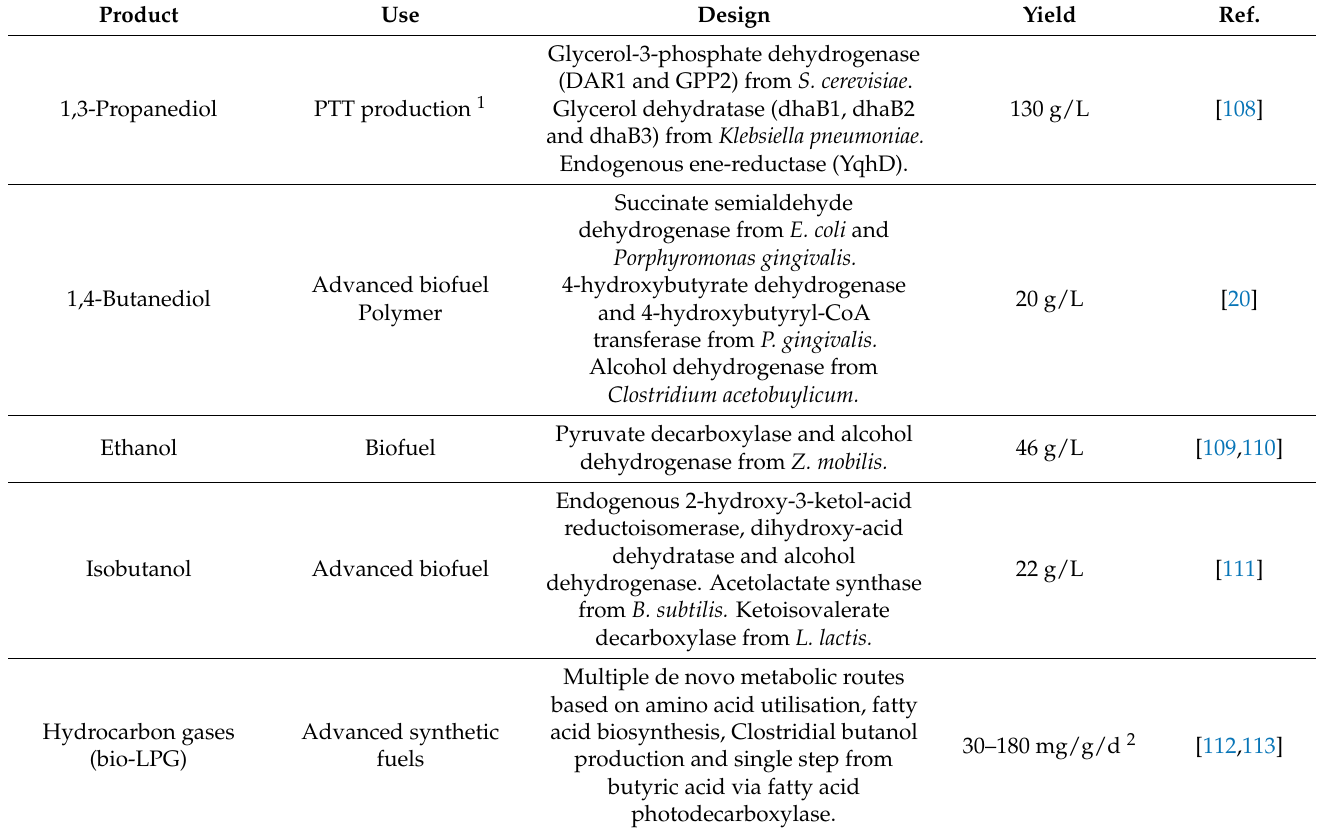
Table 1. Examples of compounds produced using engineered biosynthetic pathways in E. coli. Product Use